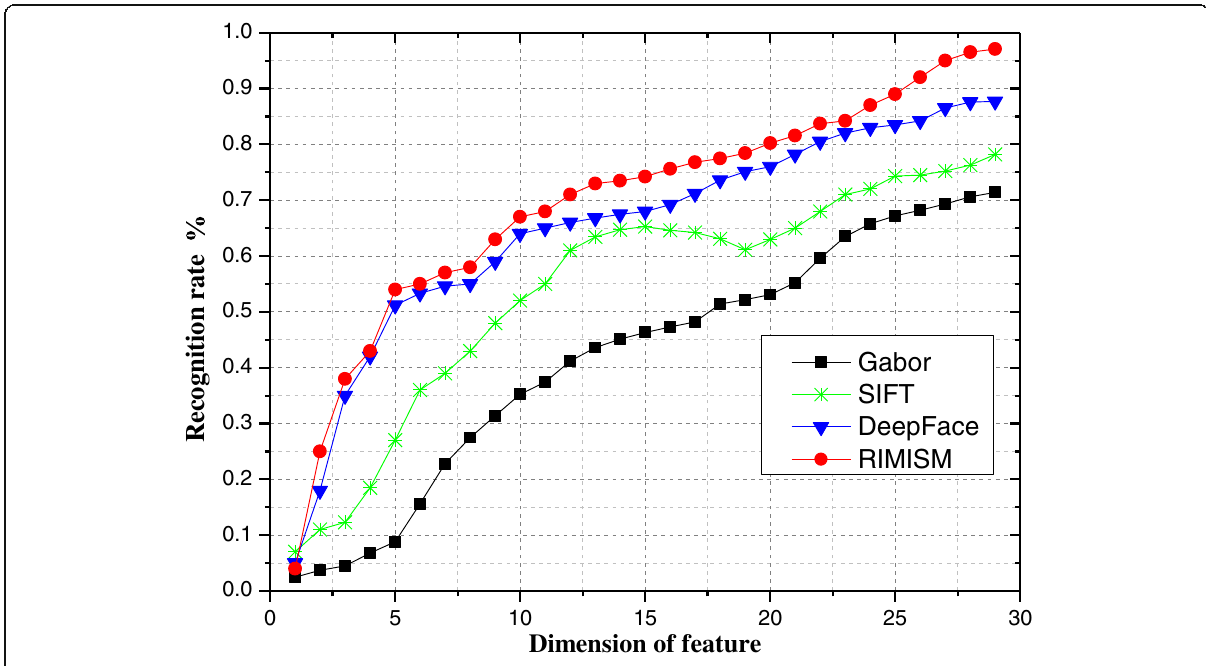
Fig. 5 Average recognition rate of ± 45° pose of FERET database